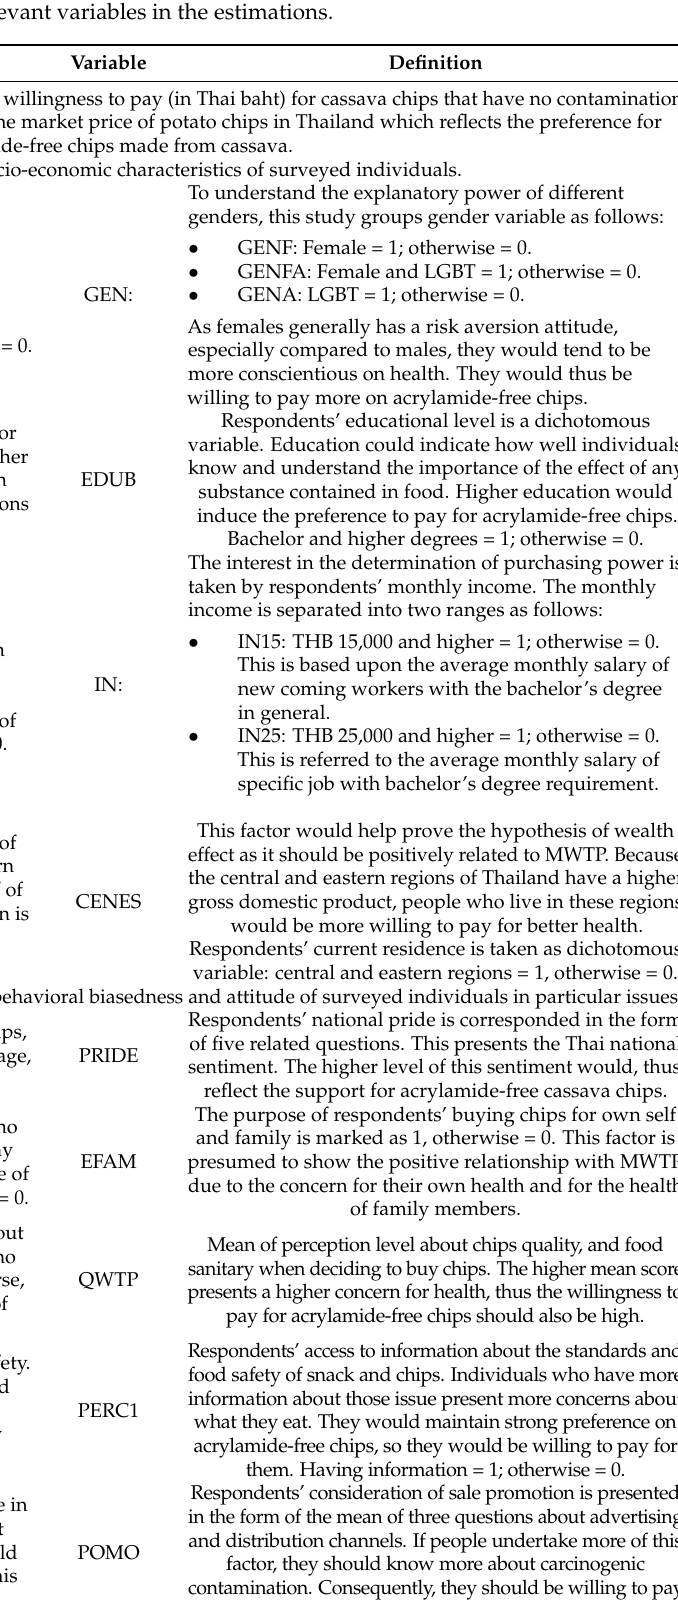
Table 2. Definition of relevant variables in the